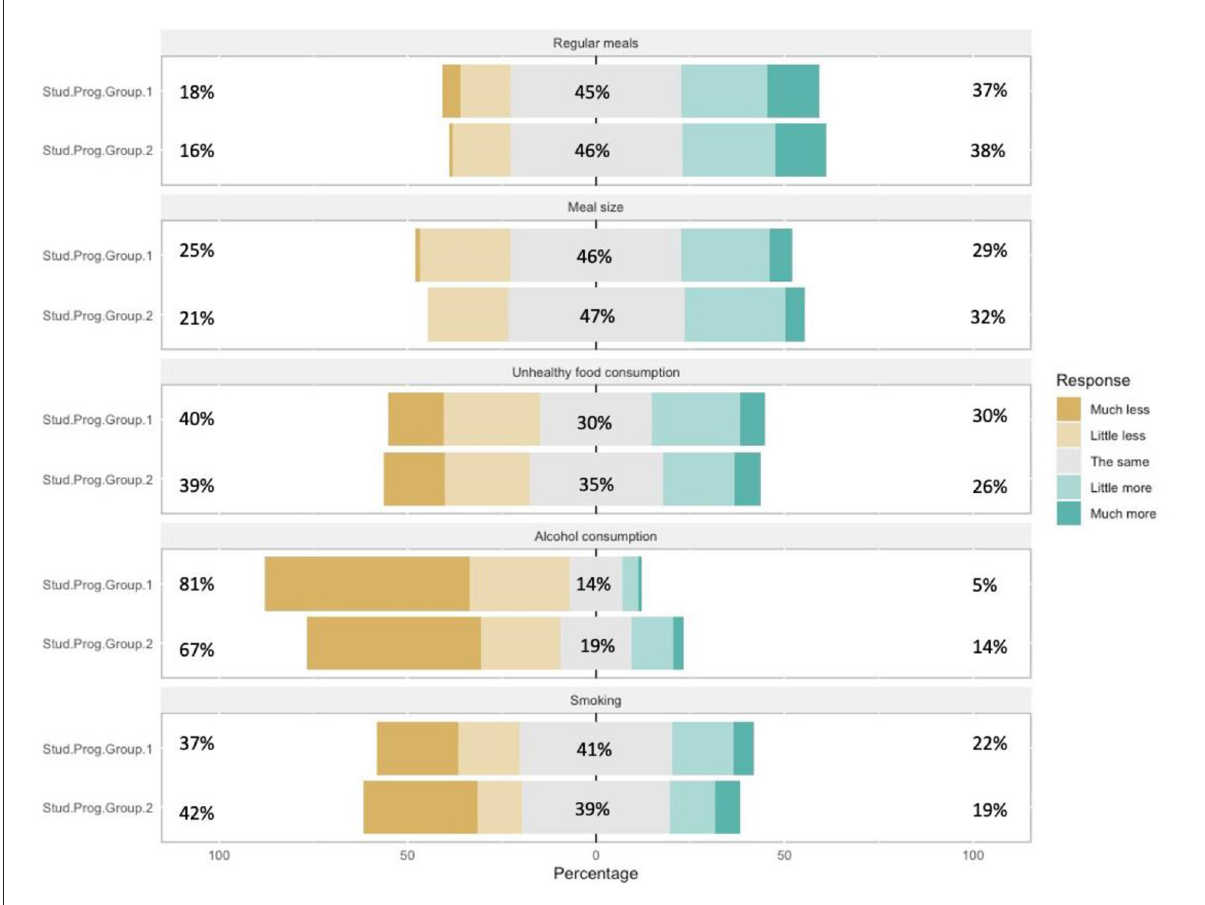
FIGURE1 Changes in eating habits and other habits – female